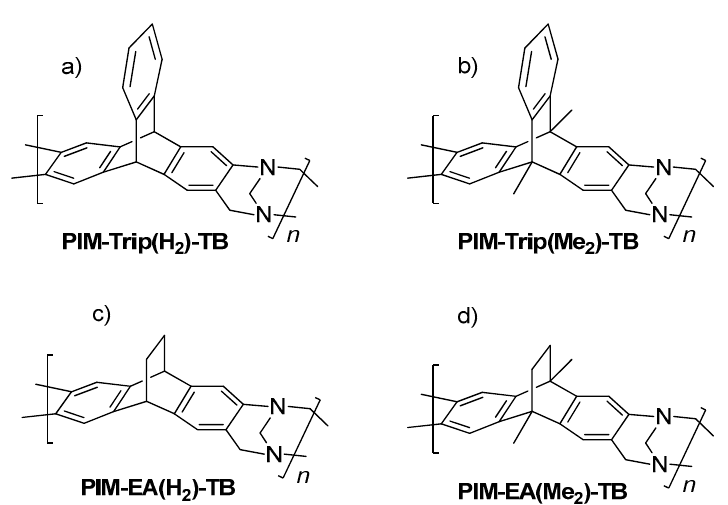
Figure 1. Chemical structure of the TB-PIMs: ( a ) PIM-Trip(H 2 )-TB [29], ( b ) PIM-Trip(Me 2 )-TB [This work], ( c ) PIM-EA(H 2 )-TB [36,40] and ( d ) PIM-EA(Me 2 )-TB [35,41].